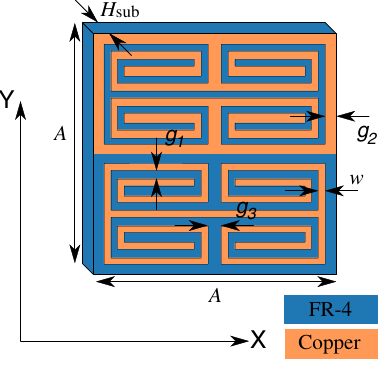
FIG. 5. Unit-cell design of the resonant self-complementary metasurface under investigation.